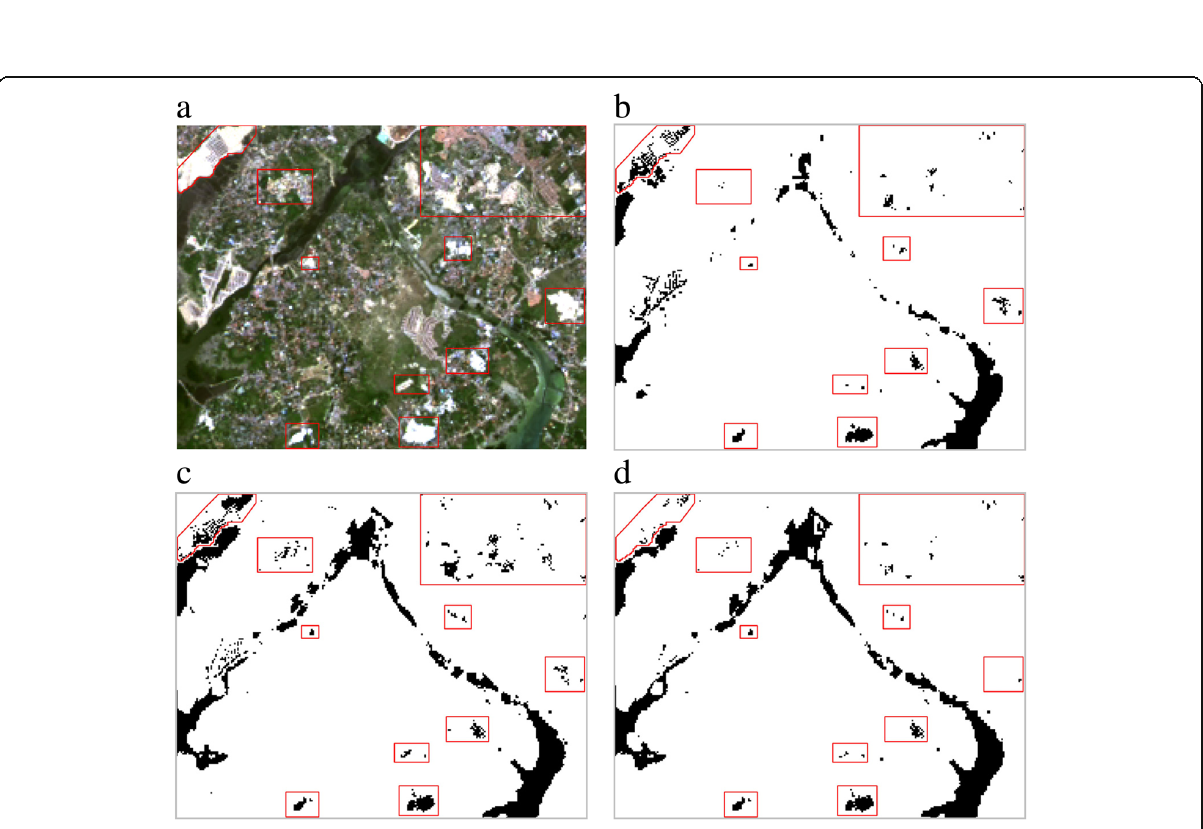
Fig. 11 Misclassification as water of white roof or white surfaces (enclosed in red) as observed in ( a ) natural composite of bands 4 – 3-2 in the water indexes of the ( b ) NDWI of McFeeters [13], ( c ) NDWI of Rogers and Kearney [14], and ( d ) MNDWI of Xu [15] based on optimum threshold